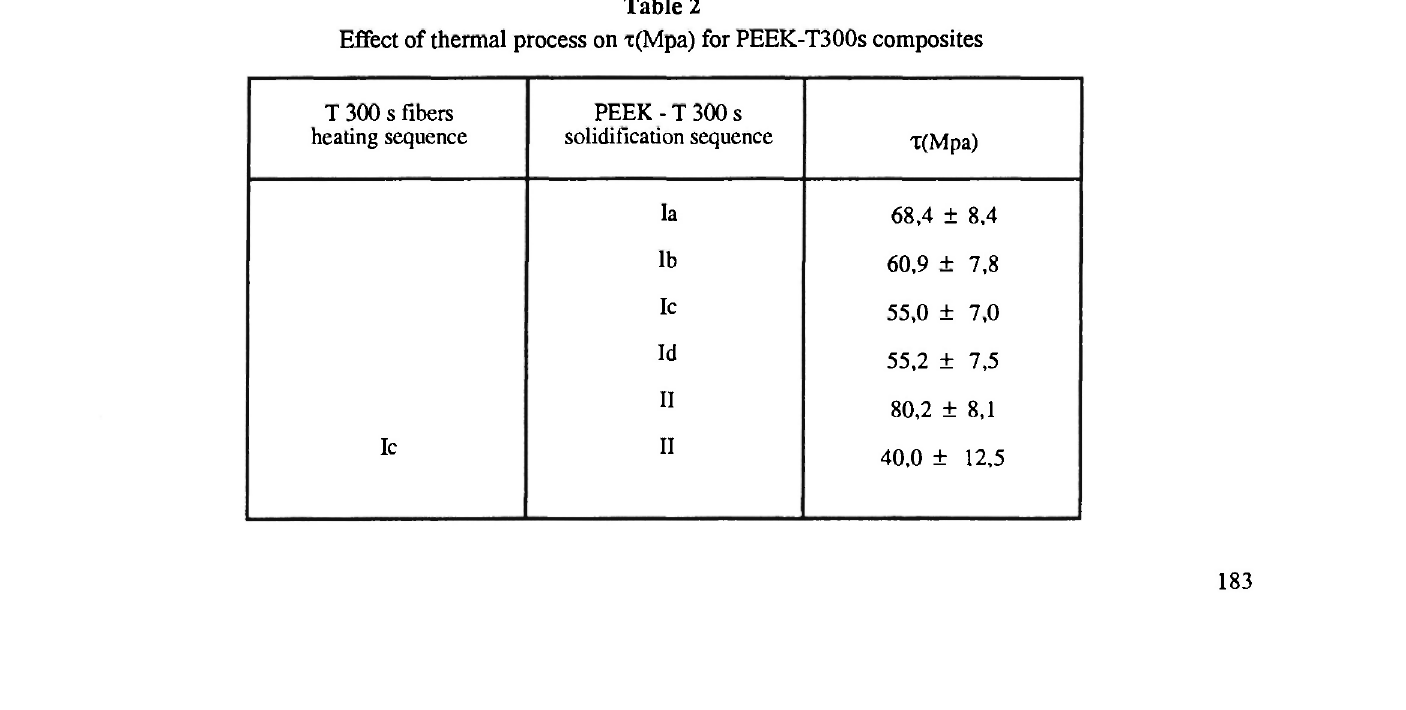
Effect of thermal process on x(Mpa) for PEEK-T300s composites